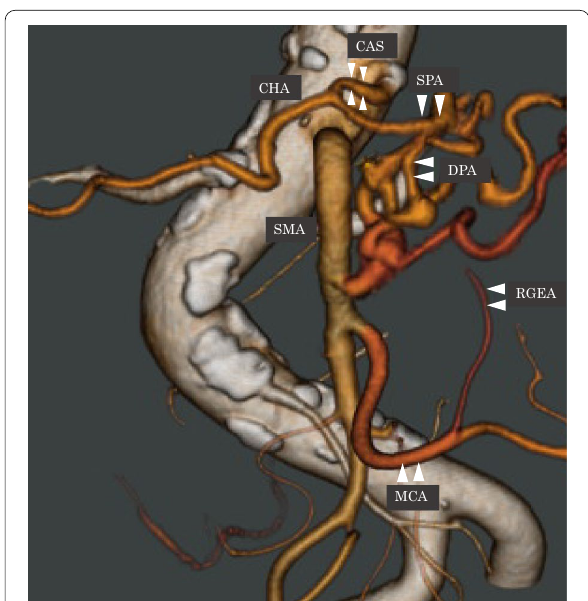
Fig. 4 Postoperative MDCT. Postoperative enhanced CT showed that sufficient inflow was provided from the lt. MCA to the RGEA, and sufficient inflow from the SMA to the SPA via the